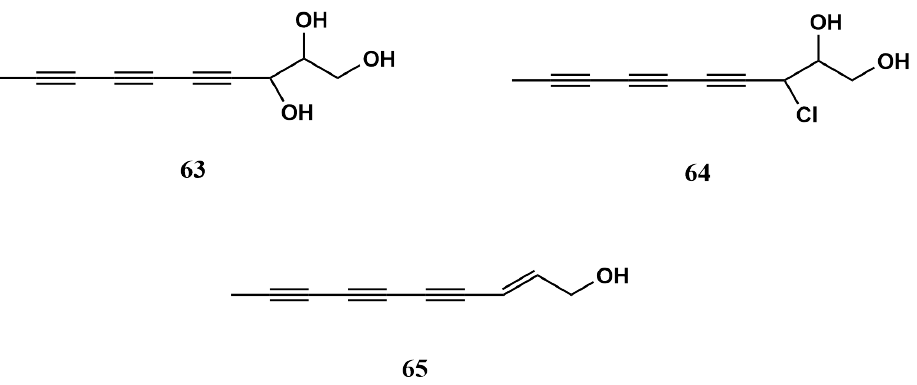
Figure 7. Polyacetylenes ( 63–65 ) from Sarcophyton tortuosum